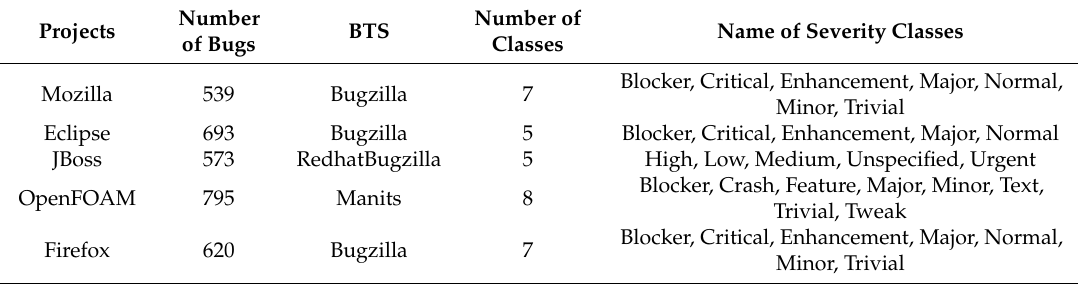
Table 1. Bug report